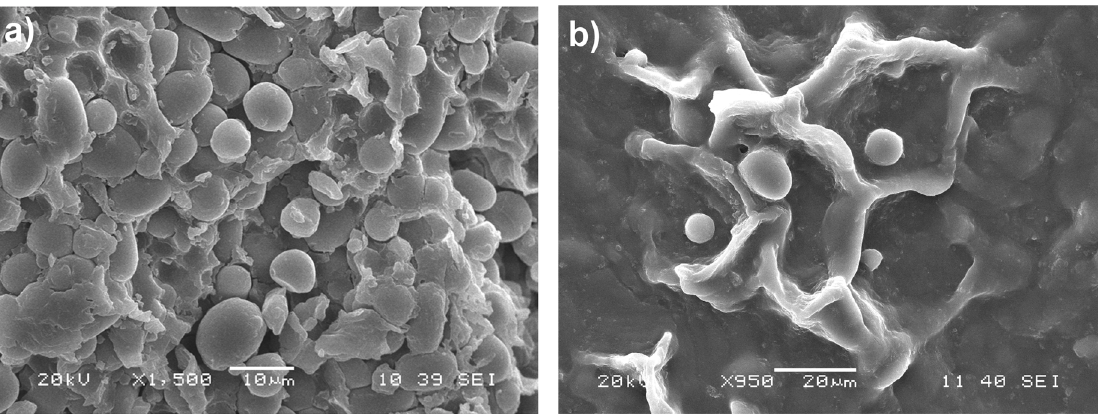
Figure 2. Scanning electron microscopy (SEM) of B. alicastrum flour: ( a ) without pretreatment; and ( b ) after thermic pretreatment 90 °C for 30 min.